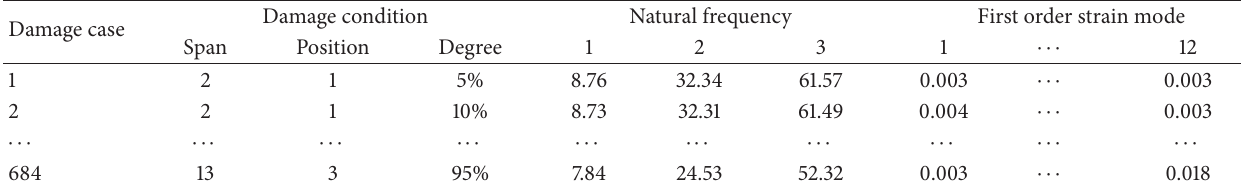
Table 3: Minimum property set 1 after reduction.